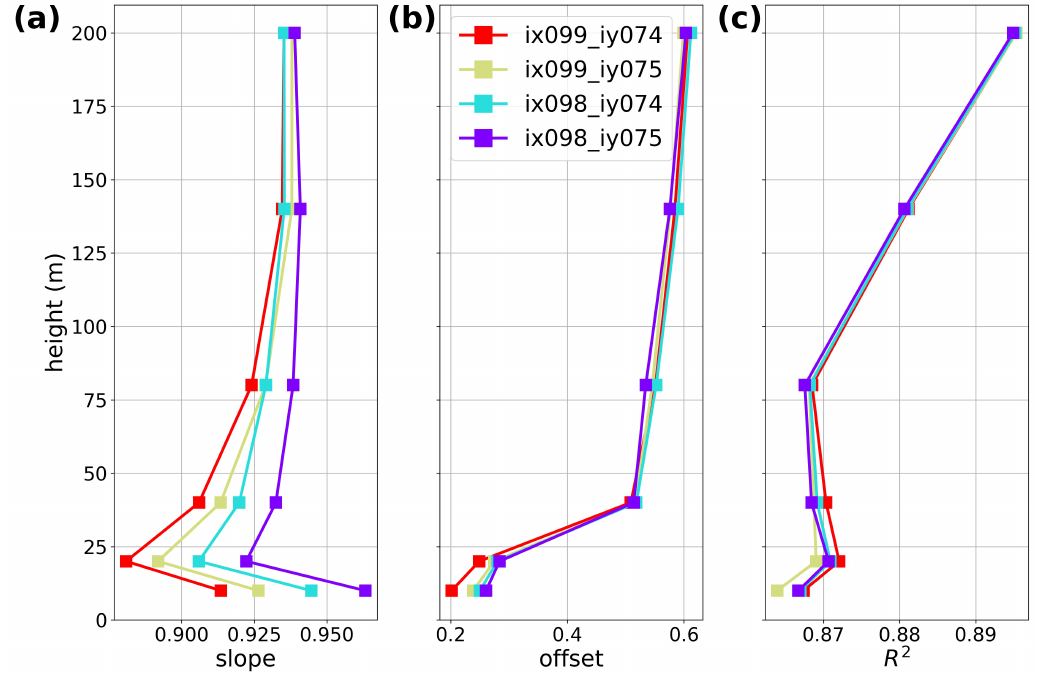
Figure A5. Height profile of the results of the linear regression ( a ) slope, ( b ) offset, and ( c ) R 2 of the wind speed data, comparing the four nearest grid points of